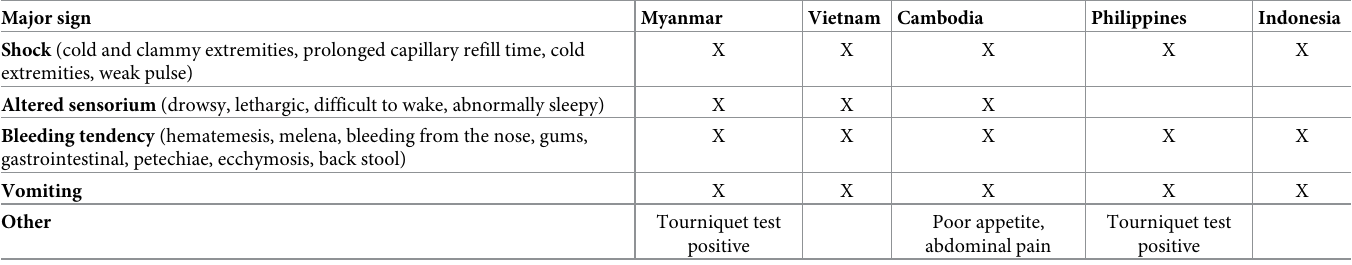
Table 2. Signs requiring urgent referral of clinically-suspected dengue in five Southeast Asian Integrated Management of Childhood Illness (IMCI) adaptations (for children 2 months to 5 years of age). Major sign